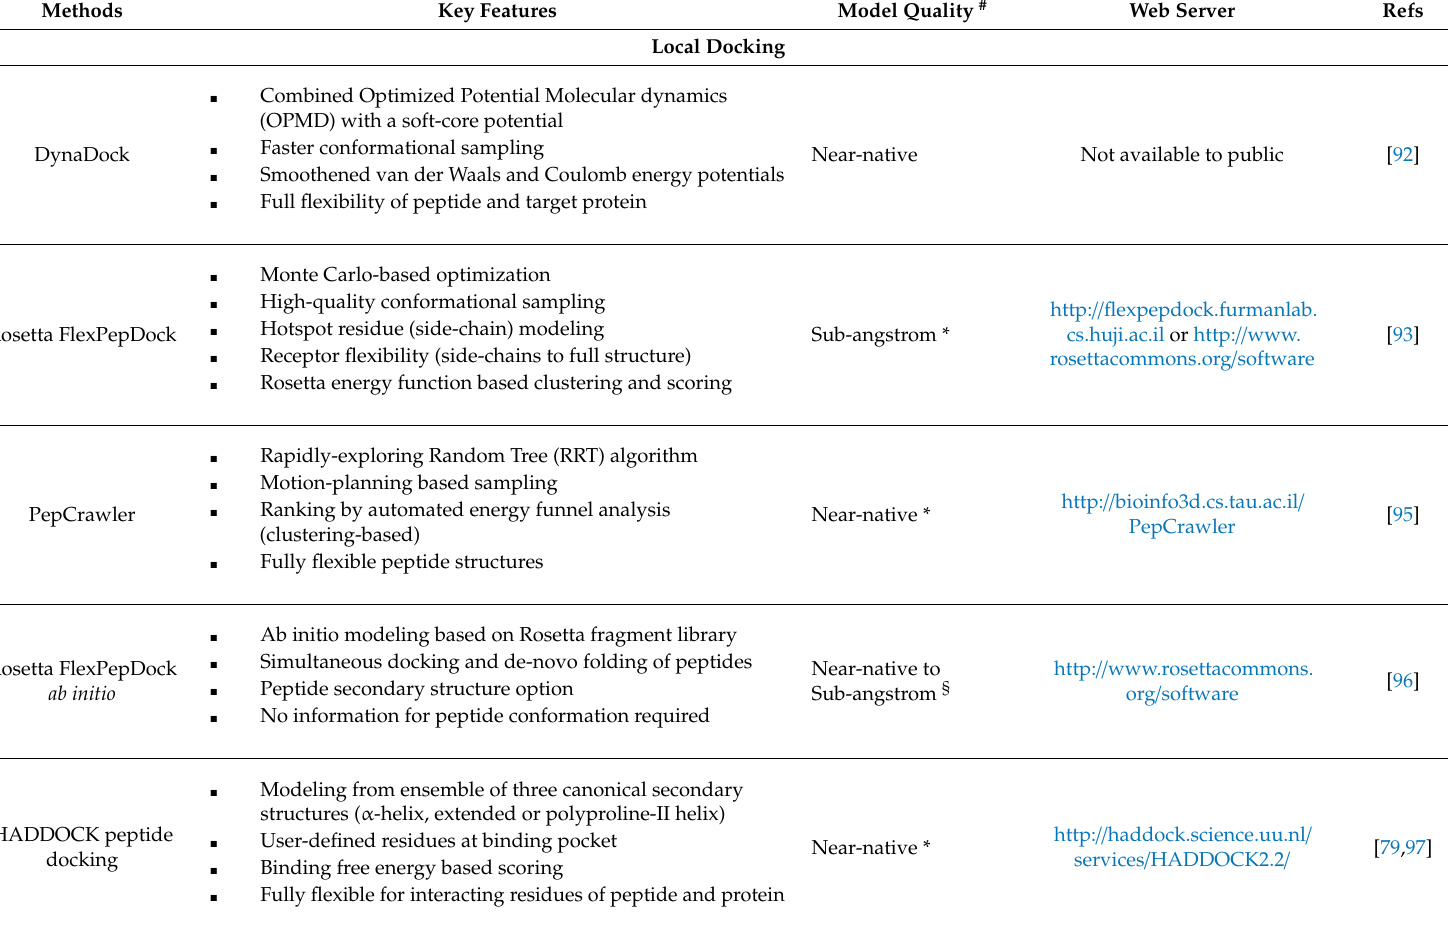
Table 2. Summary for peptide–protein interactions docking